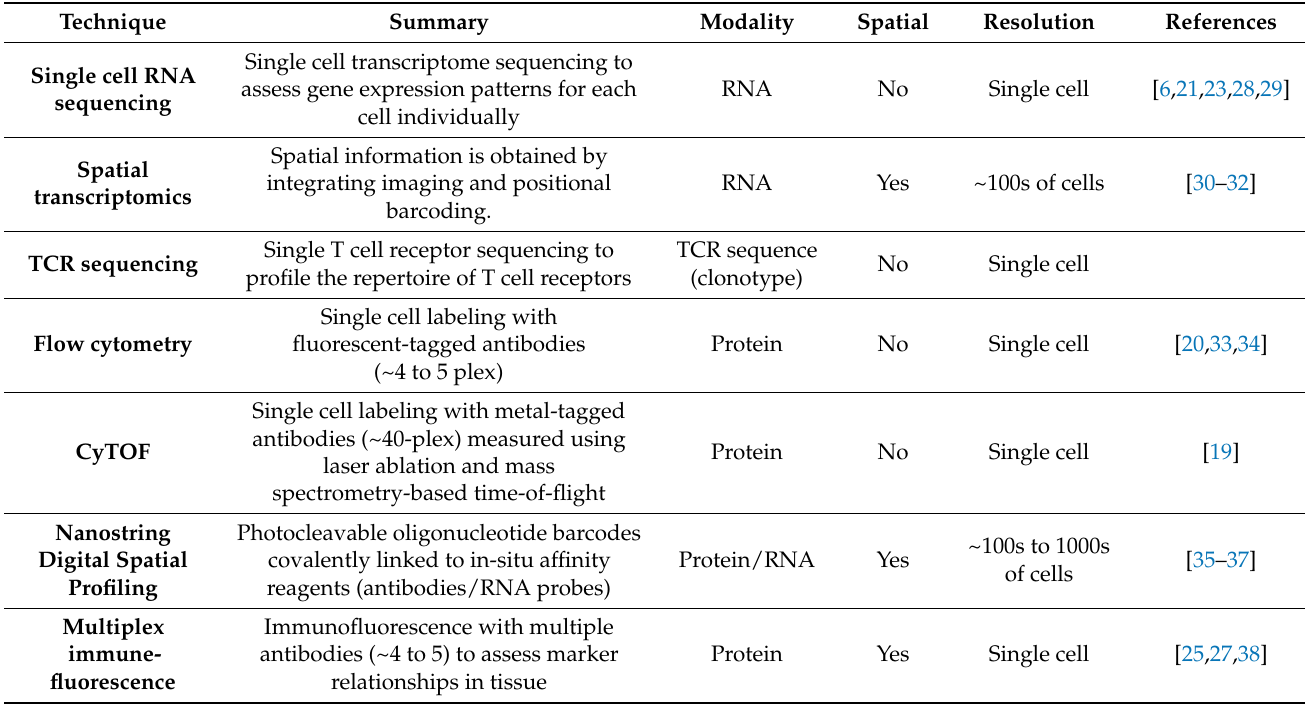
Table 1. Methods to generate high-dimensional phenotypic